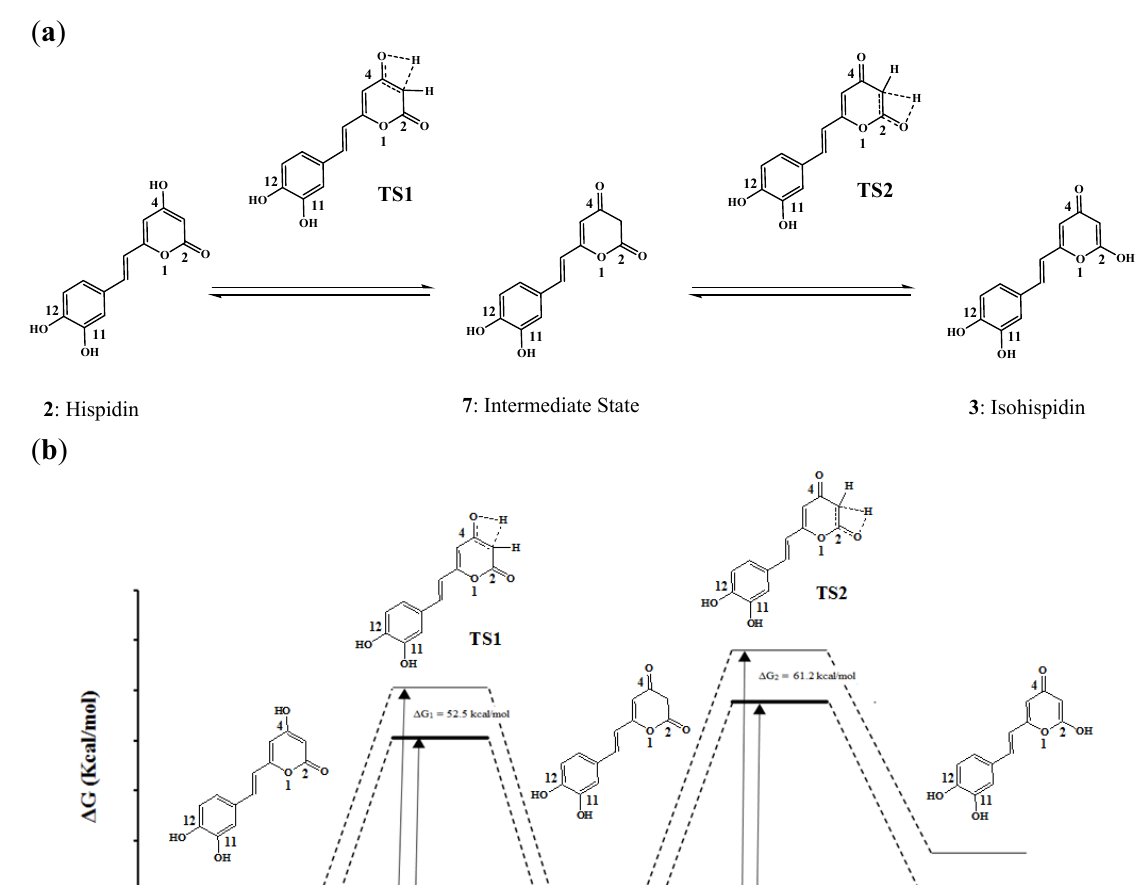
Figure 3. ( a ) Tautomerism of hispidin to isohispidin; ( b ) tautomerism chemical profiles in gas and solvent; and ( c ) tautomerism chemical profile in hybrid model (PCM + one assisted solvent